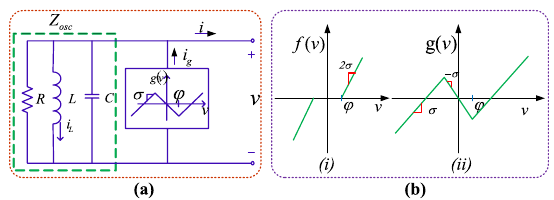
Fig. 7 3-phase VSI with VOC in islanded representation is shown in Fig. 5a. VOC is composed of two subsystems, i.e., an RLC circuit and a voltage- dependent-current-source (VDCS). These are, derived from the nonlinear deadzone oscillator (DZo), as: